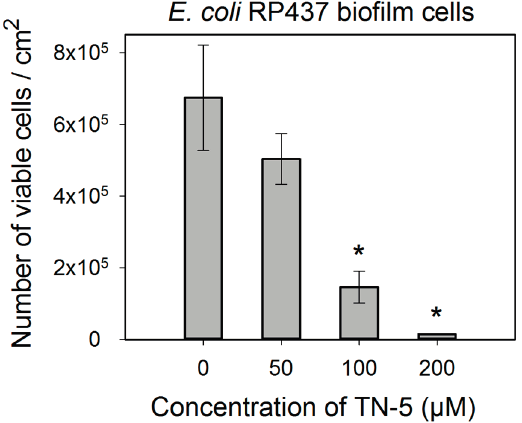
Figure 4. Effects of TN-5 on E. coli RP437 biofilms. The biofilms were cultured for 24 h in LB on stainless steel coupons prior to treatment with TN-5. All significant differences (compared to the TN-5 free control) with p < 0.01 are marked with an asterisk. Note: Data are plotted in linear